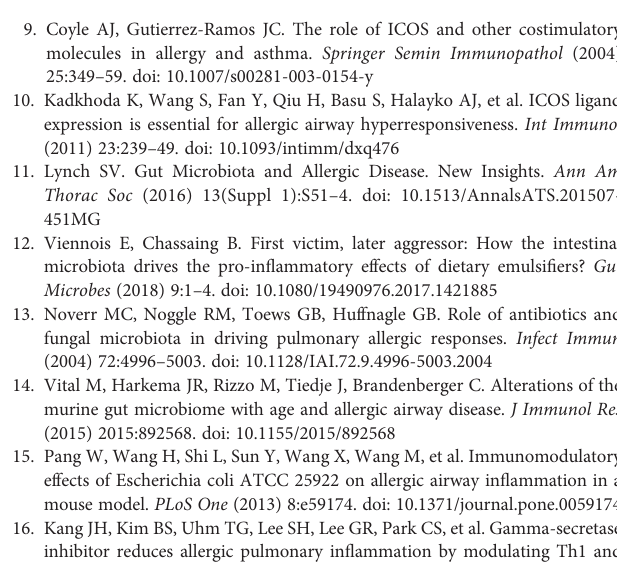
Supplementary Figure 1 | Mast cell in fi ltration assessed on Toluidine Bluestained nasal mucosa and lung. (A) Mast cells were round or oval, with dark blue nucleus and purplish red or dark purple cytoplasm. Original magni fi cation was ×200. (B) Number ofmast cells in the nasal mucosa and lung. Bar graphsrepresent mean ± SD. * P < 0.05, ** P < 0.01. Supplementary Figure 2 | Eosinophil in fl ammation assessed on hematoxylin and eosin (HE) stained nasal mucosa and lung. (A) The eosinophils were round and the eosinophilic granules in cytoplasm were brick red or bright red. Original magni fi cation was ×200. (B) Number of eosinophils in the nasal mucosa and in fl ammation score of lung. Bar graphs represent mean ± SD. ** P < 0.01. Supplementary Figure 3 | B. thetaiotaomicron induced ICOS expression on Tregs and ampli fi cation of IL-10-expressing CD4 + Foxp3 + Tregs in spleen. Representative scatter plots and ration of the fraction of CD4 + Foxp3 + cells (A) , CD4 + ICOS + T cells (B) , and CD4 + ICOS + Foxp3 + regulatory T cells (C) . Representative histogram showing expression of IL-10 in CD4 + Foxp3 + Tregs (D) . Bar graphs represent mean ± SD. n = 6, * P < 0.05, ** P < 0.01. Supplementary Figure 4 | B. thetaiotaomicron induced ICOS expression on Tregs and ampli fi cation of IL-10-expressing CD4 + Foxp3 + Tregs in mesenteric LNs. Representative scatter plots and ration of the fraction of CD4 + Foxp3 + cells (A) , CD4 + ICOS + T cells (B) and CD4 + ICOS + Foxp3 + regulatory T cells (C) . Representative histogram showing expression of IL-10 in CD4 + Foxp3 + Tregs (D) . Bar graphs represent mean ± SD. n = 6, * P < 0.05, ** P <